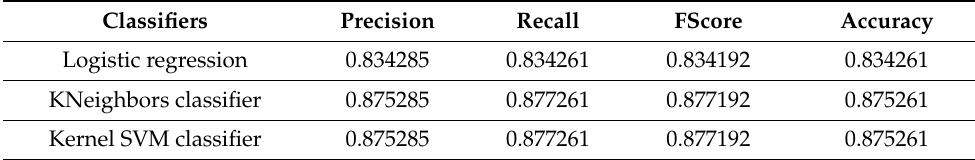
Table 21. Extra trees classifier metrics before feature